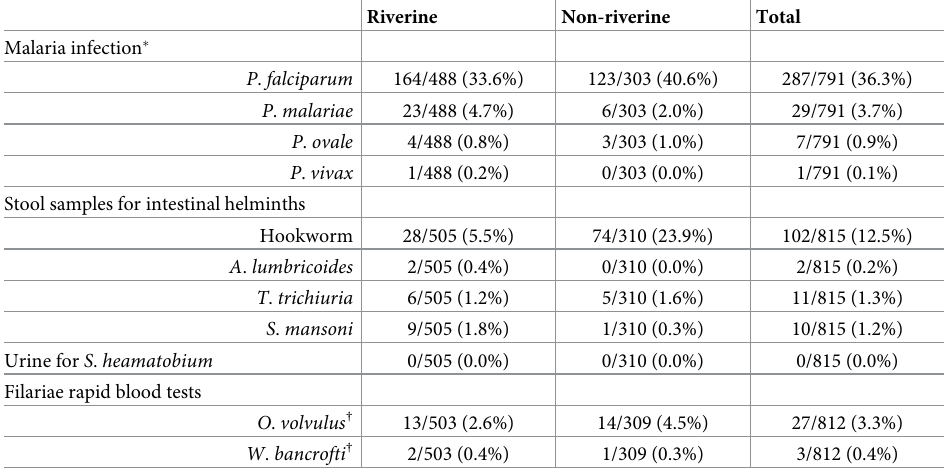
Table 2. Prevalence of parasitic infections in participants in Mambolo